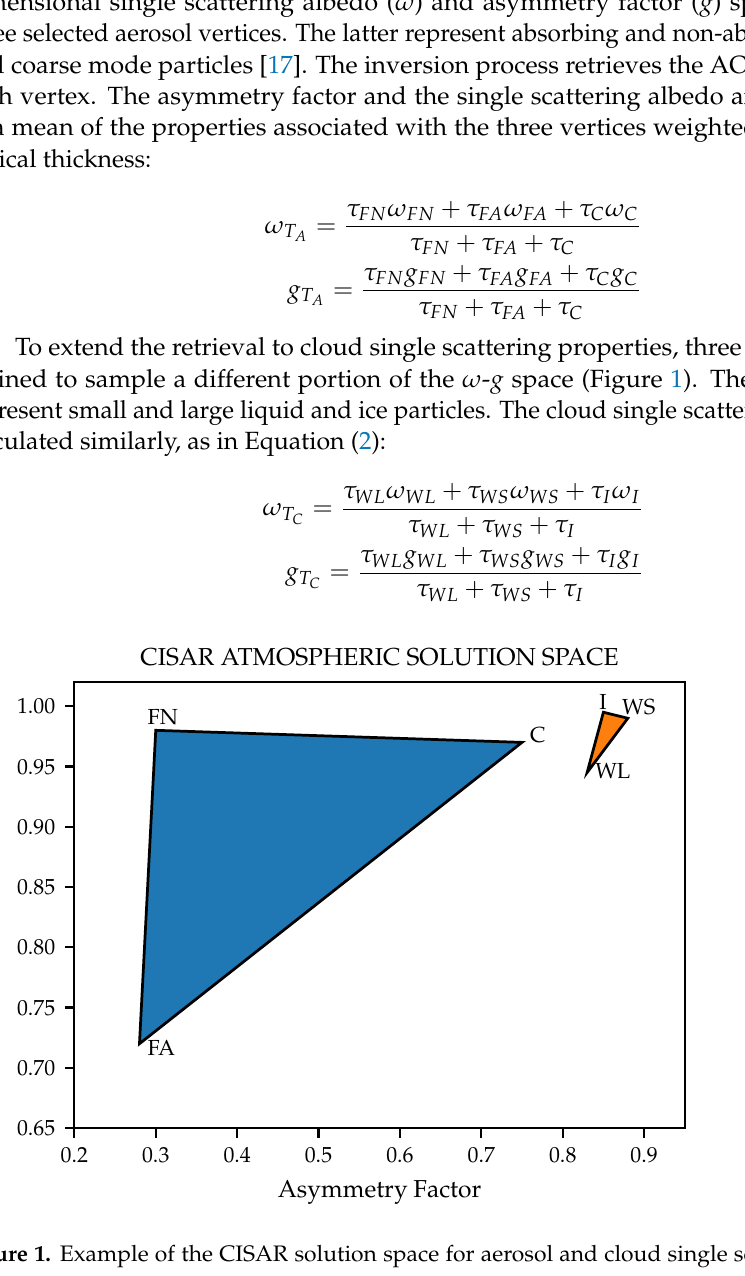
Figure 1. Example of the CISAR solution space for aerosol and cloud single scattering properties. The x-axis represents the asymmetry factor and the y axis represents the single scattering albedo. The blue triangle represents the solution space for the aerosol particles, delimited by the three vertices associated with fine absorbing (FA), fine non-absorbing (FN), and coarse (C) mode particles. The orange triangle is the solution space in which the cloud properties are allowed to change, delimited by the vertices representing small and large water (WS and WL, respectively) and ice (I)